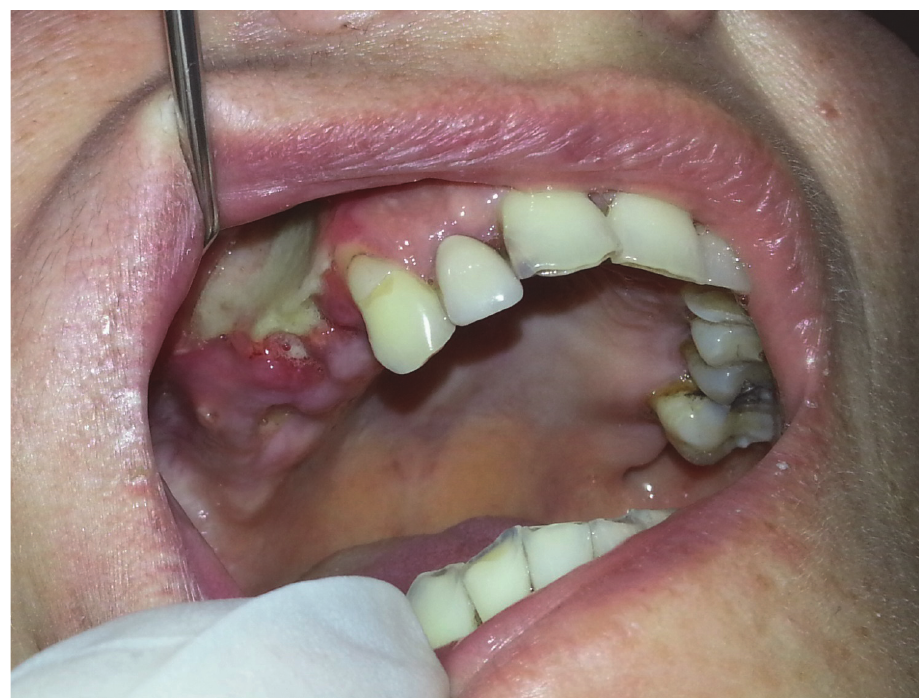
Fig. 1. MRONJ emerged after 6 years exposure to oral ibandronate in 53-year-old women.